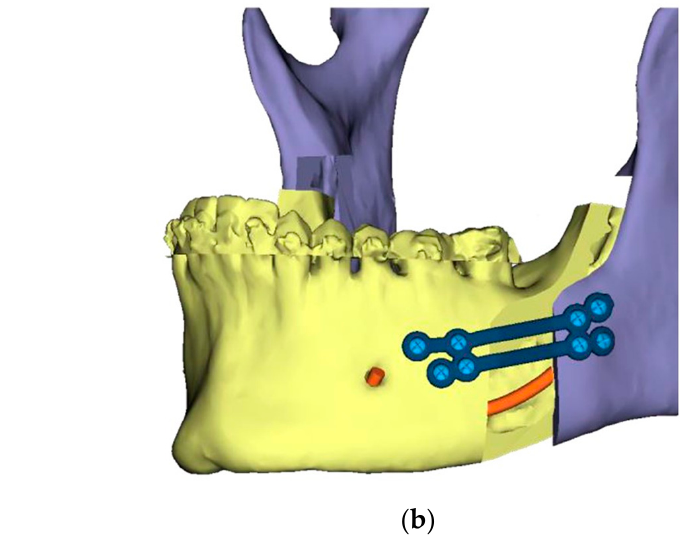
Figure 7. Titanium 3D Printed Plate for Mandible for use with Matrix ORTHOGNATHIC Ø1.85 mm screws—All screw pre-drilling guided using surgical guides. ( a ) Right side view; ( b ) Left side view.